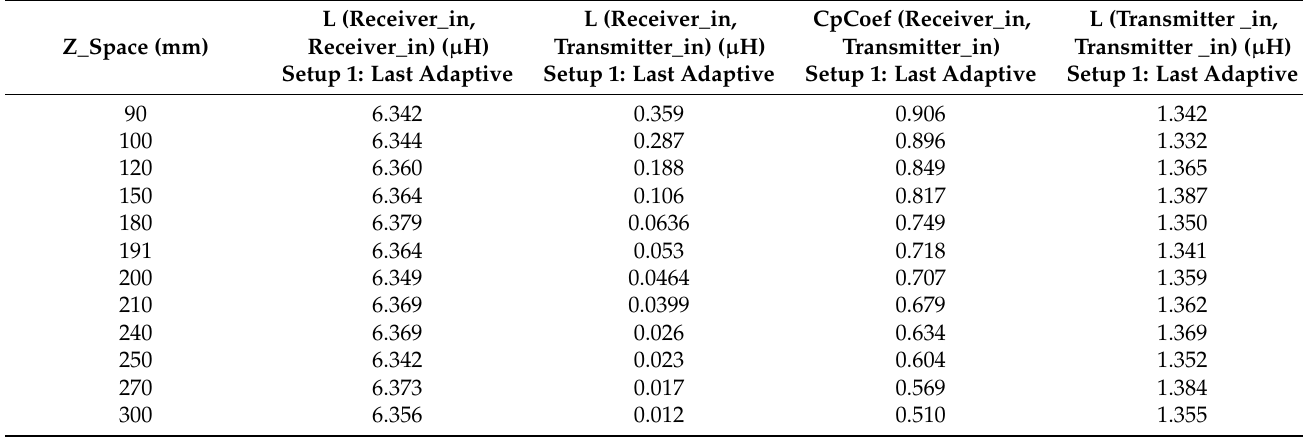
Table 3. Numerical results for mutual inductances between the transmitting coil and receiving coil with the coupling coefficient.